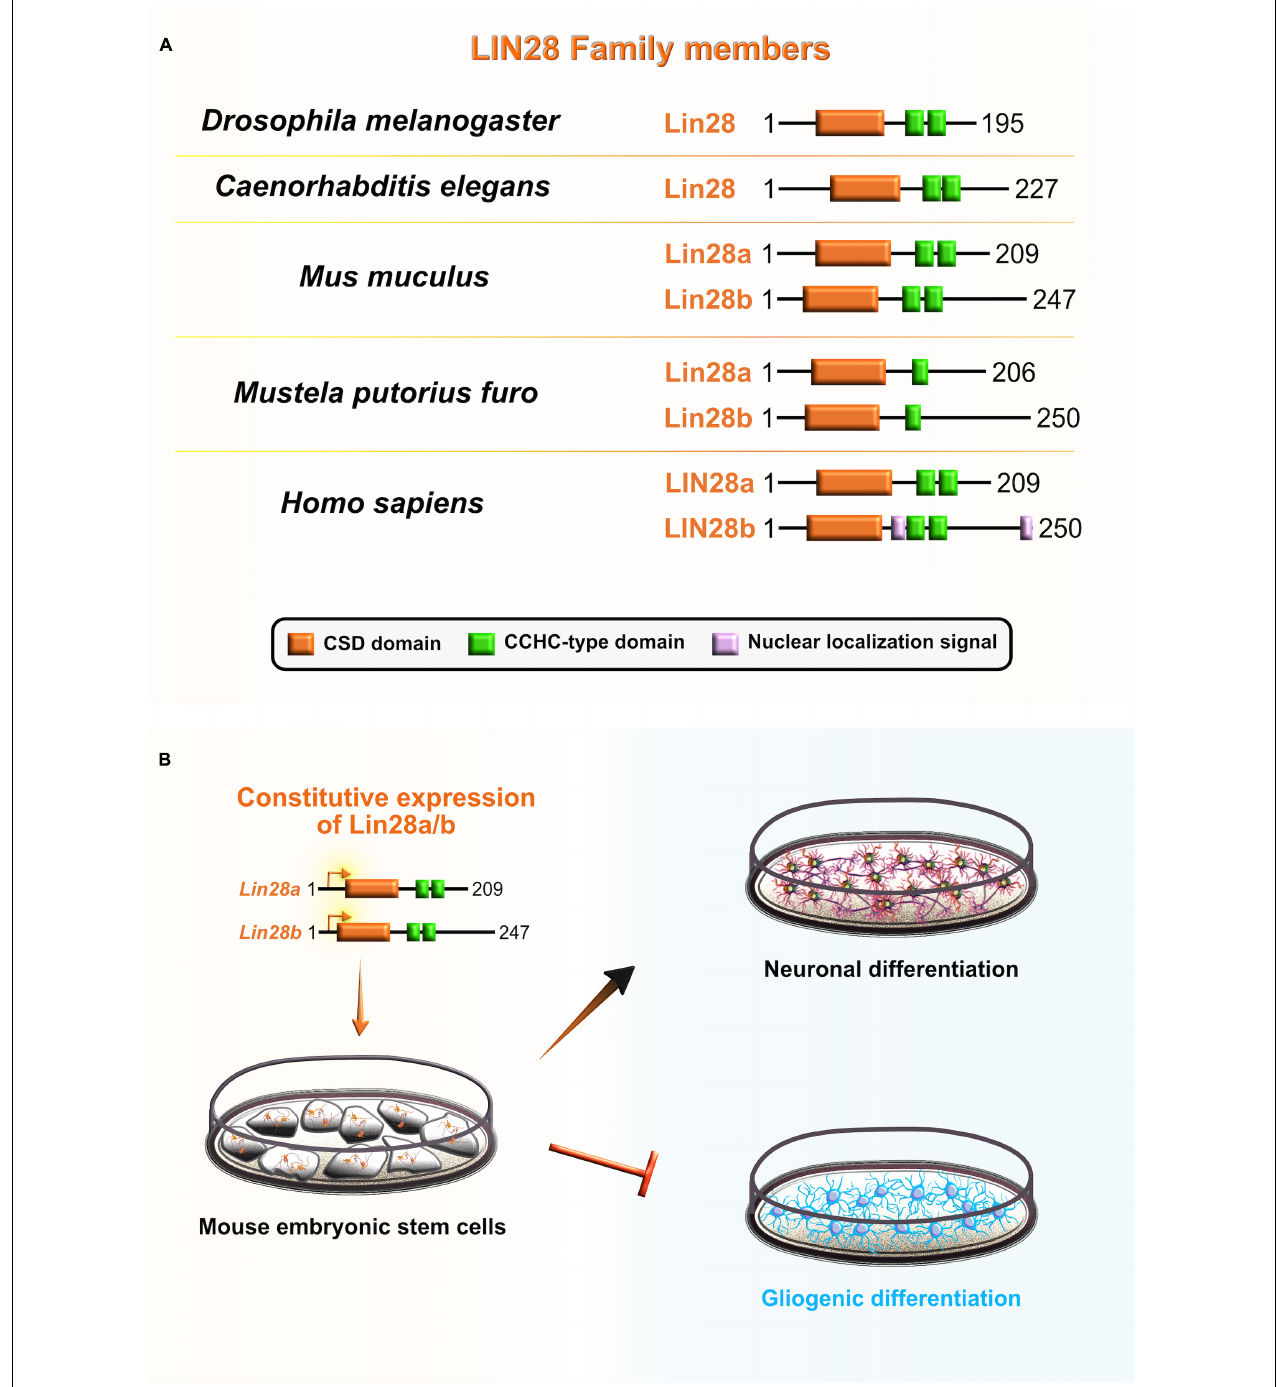
FIGURE 7 | Role of lineage abnormal 28 (LIN28) during neocortical development. (A) Schematic presentation of structural domains of evolutionarily conserved RNA-binding protein LIN28 in Drosophila melanogaster , Caenorhabditis elegans , Mus musculus , Mustela putorius furo , and Homo sapiens as per UniProt database (https://www.uniprot.org). Different domains are represented as colored boxes, also in order from left to right: cold shock domain (CSD; orange), CCHC type zinc finger domains (green), nuclear localization signal motif (rose). The UniProtKB accession numbers are indicated below for each member of LIN28 family in D. melanogaster : cell lineage abnormal 28 (Lin28) (Q9VRN5); C. elegans : Lin28 (P92186); M. musculus : Lin28a (Q8K3Y3), Lin28b (Q45KJ6); M. putorius furo : Lin28a (M3YWA5), Lin28b (M3YDK6); and H. sapiens : LIN28a (Q9H9Z2), LIN28b (Q6ZN17). (B) Lin28 is expressed at high levels during early neocortical development. These levels rapidly decrease at later stages of neurogenesis to allow for the sequential generation of neuronal and glial fates. The constitutive expression of Lin28 in undifferentiated stem cells switches off the generation of glial cell fates while supporting the establishment of neuronal fates.